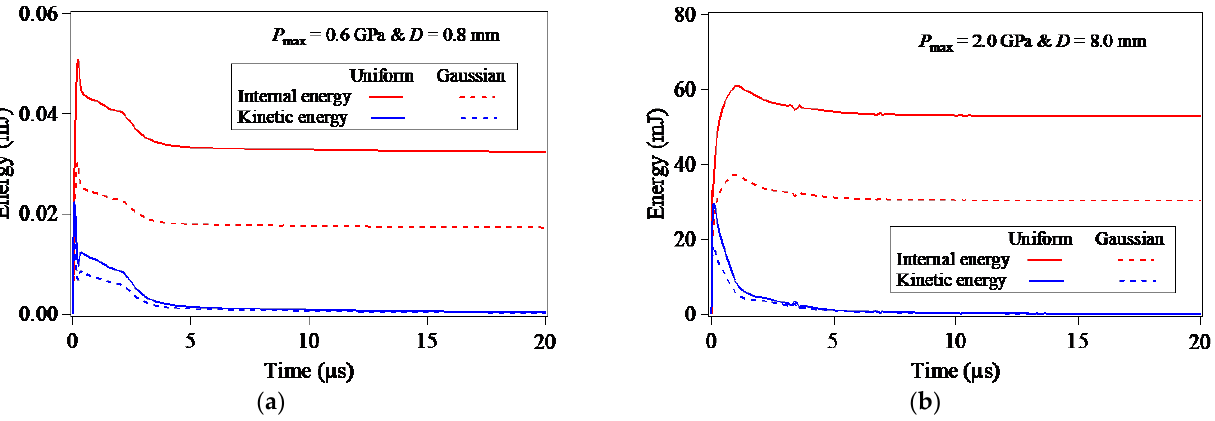
Figure 2. Evolutions of internal energies and kinetic energies stored in the target material during the LSP process: ( a ) P max = 0.6GPa& D = 0.8mm; ( b ) P max = 2.0GPa& D =